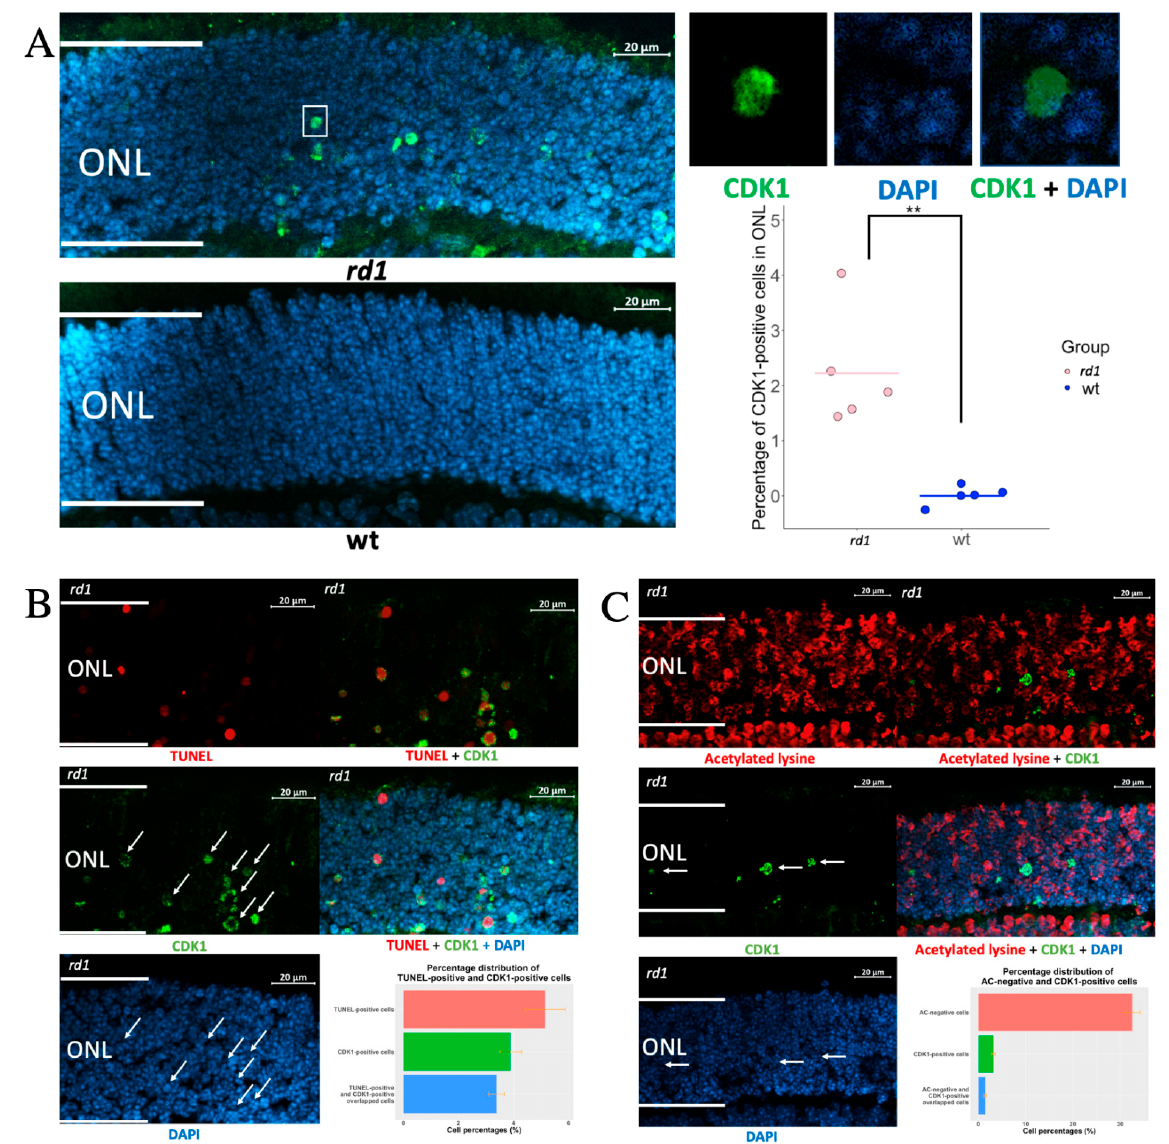
Figure 1. Evaluation of CDK1 expression within the ONL. ( A ) Immunostaining of CDK1 (green) within the ONL of rd1 and wt strains at P11. The dot chart shows the comparison of CDK1-positive cells within ONL between rd1 and wt (n = 5); ( B ) Co-staining of CDK1 (green) and TUNEL (red) within ONL from rd1 retinas, with bar chart showing the distribution of TUNEL-positive and CDK1- positive cells (n = 5). ( C ) Co-staining of CDK1 (green) and acetylated lysine (AC, red) within the ONL from rd1 retinas, with bar chart showing the distribution of CDK1 + cells and AC-negative cells (n = 5). DAPI (blue) was used as nuclear counterstain. For graphs, bars represent mean ± S.D, ** p < 0.01. ONL = Outer nuclear layer. Arrows point to the CDK1-positive cells and associated DAPI-positive